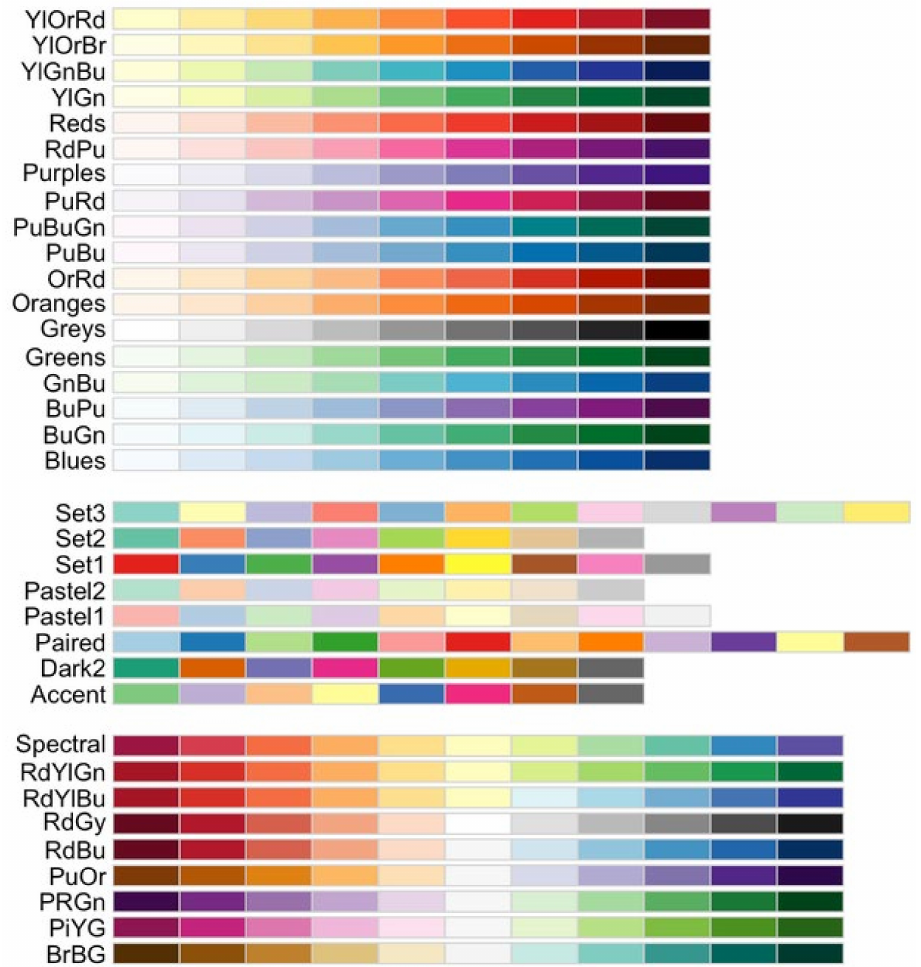
Figure 2. ColorBrewer color schemes: sequential, qualitative, and diverging, respectively [44]. For each color scheme in the ColorBrewer tool, the user can select the number of colors or shades to use when creating a map. Figure 3 shows a sequential scheme that ranges from pink to blue-green and contains three to nine color classes in ascending order. Using fewer color classes in a map provides better contrast between classes, while more classes provide more options for displaying and reading the data. In ascending order, lighter hues in sequential schemes and perceptually colder colors in diverging schemes are used to represent lower values, while darker hues and perceptually warmer colors are used to represent higher values. In descending order, the representation is reversed. Exceptions with respect to the order of colors are qualitative color schemes in which the colors are not ordered (see Figure